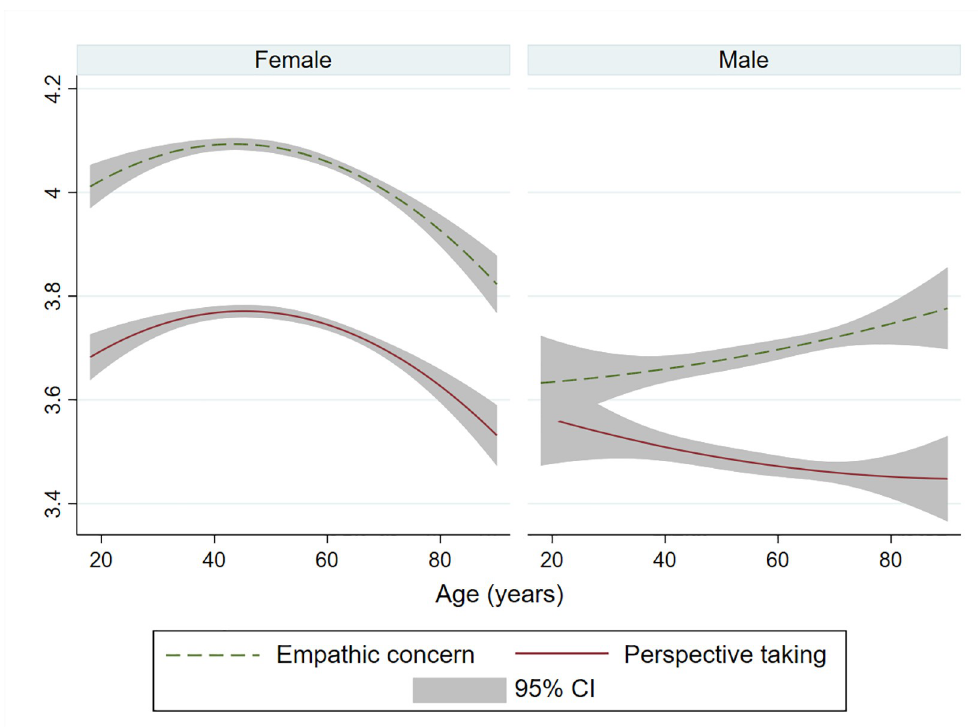
Fig 1. Mean empathic concern and perspective taking scores by age and gender. Predicted mean empathic concern (EC) and perspective taking (PT) by age in women and men, from regression of EC or PT on age and age 2 with 95% confidence interval